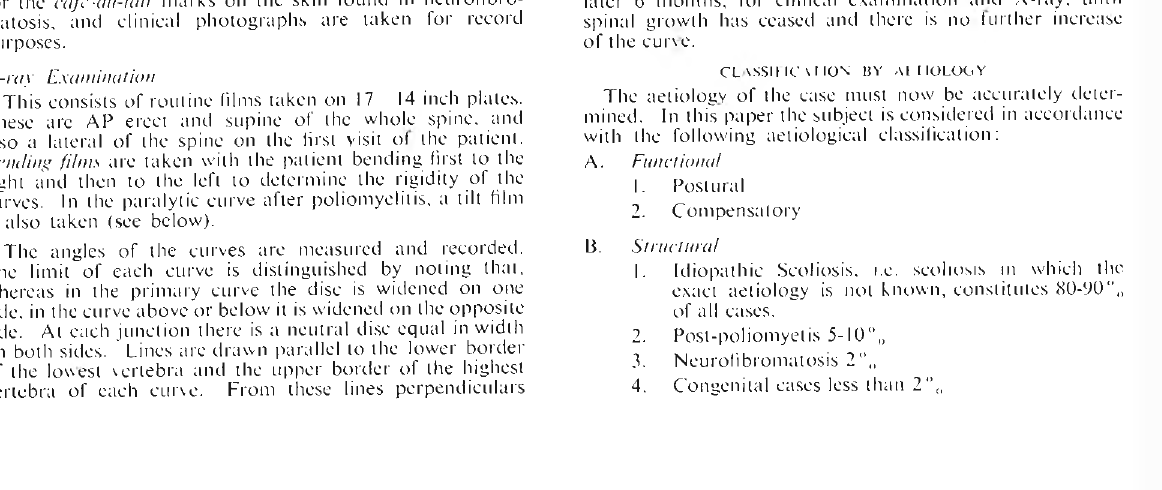
A t horn co-lu m liar idiopathic curve. 18- LI 71 (maior curve) with upper secon­ dary curve, 12 17 39 , and lower secon­ dary eur\e, L2—SI 35